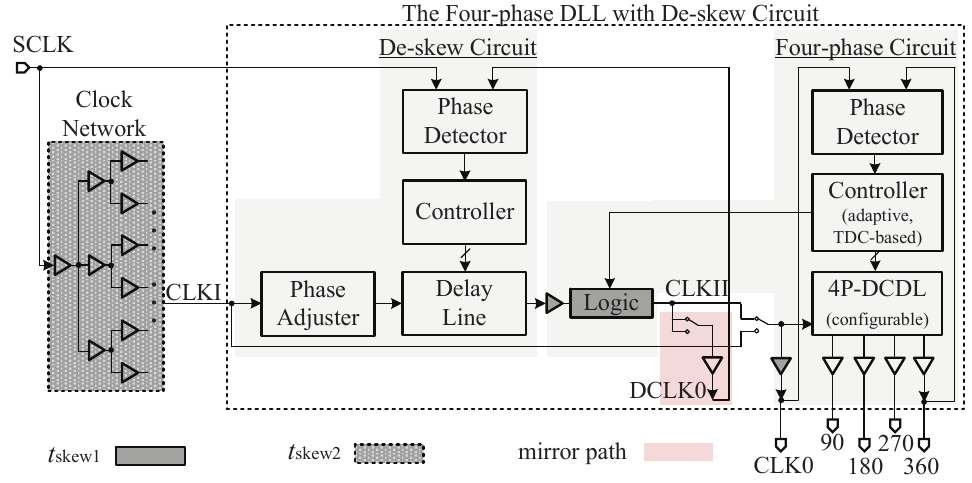
Figure 1. The proposed four-phase all-digital DLL with de-skew circuit